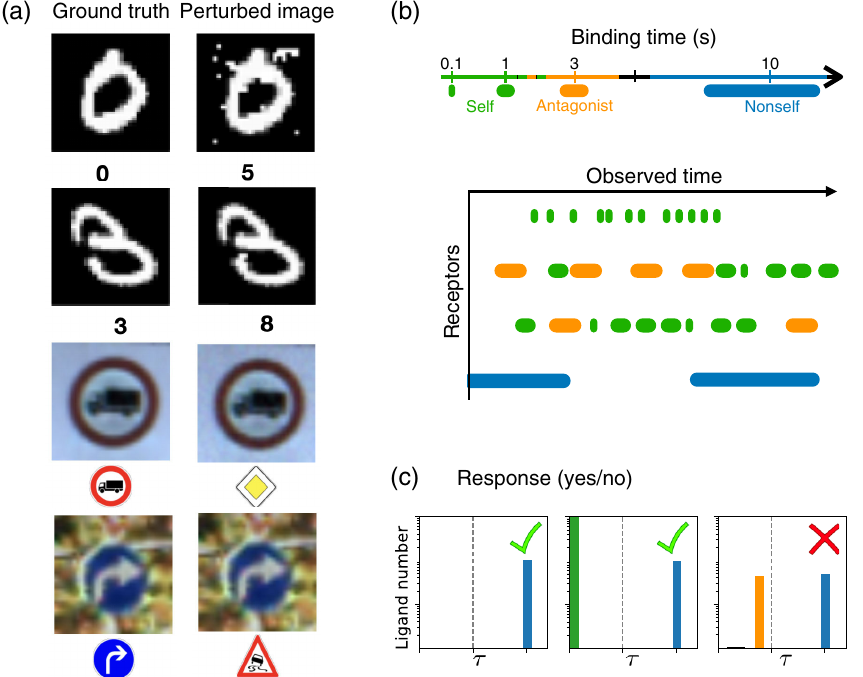
FIG. 1. Ligand discrimination and digit recognition tasks. (a) Adversarial examples on digits and road signs. Reproduced from Ref. [7], Courtesy of Nicolas Papernot. Left column displays original images with categories recognized by machine-learning algorithms, right column displays images containing targeted perturbations leading to misclassification. (b) Schematics of ligand- binding events showing typical receptor occupancy through some observed time during cellular decision-making using T-cell terminology (self vs nonself). The colored bars correspond to self (green), antagonist (orange), and nonself (blue) ligands binding to receptors. Their lengths are indicative of the binding time τ i , whereas their rate of binding measures the on rate k on i . (c) Different ligand distributions give different response. The vertical dotted line indicates quality τ d . Decision should be to activate if one observes ligands with τ > τ d , so on the right of the dotted line. In an immune context, T cells respond to ligand distributions of agonists alone and agonists in the presence of nonagonists (with very small binding times τ ), while the T cell fails to respond if there are too many ligands just below threshold τ d